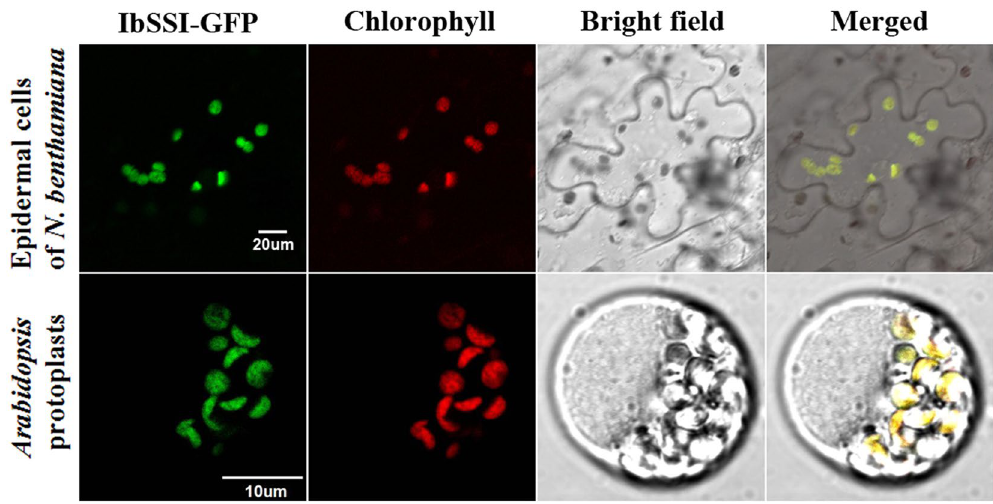
Figure 3. Subcellular localization of IbSSI protein. Upper row: confocal images of green fluorescence of IbSSI-GFP fusion protein are shown in N. benthamiana leaf hypodermal cells, which co-localized with the autofluorescence of chloroplasts. Scale bar = 20 μ m. Lower row: co-localization of IbSSI-GFP signals with autofluorescence of chloroplasts in Arabidopsis mesophyll protoplast. Scale bar = 10 μ